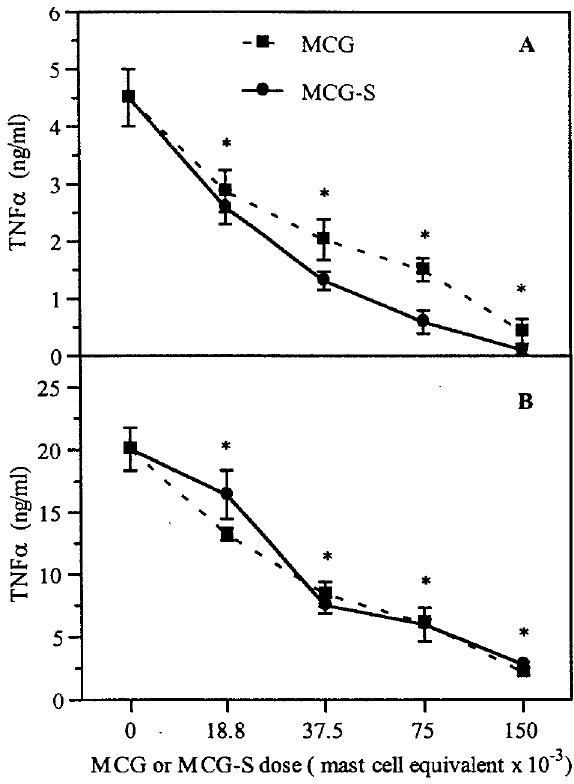
FIG. 3. Dose response effect of MCG or MCG-S on macro- phage TNF a production. Adherent macrophages (200,000) were cultured with LPS + IFN g in the presence or absence of the indicated doses of MCG or MCG-S (mast cell equivalent). After 6h of culture, media were collected and TNF a levels were measured by ELISA (panel A) and bio-assay (panel B) utilizing L929 cells as the target. Each value presented is the mean ± SEM of quadruplicate determinations. There is no significant difference between the effects of MCG and MCG- S. This is representative of three experiments.* P <0.05 vs. no MCG added.